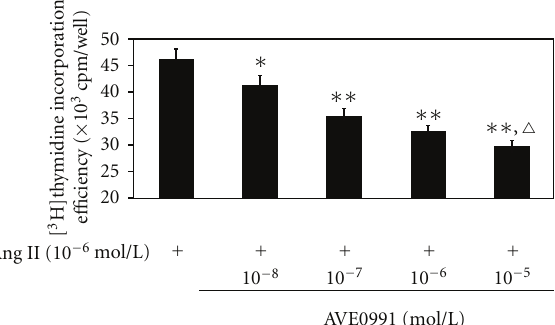
Figure 2: The e ff ect of various concentrations of AVE0991 on the VSMCs [ 3 H]thymidine incorporation e ffi ciency when stimulated with Ang II. ∗ P < 0 . 05; ∗∗ P < 0 . 01 versus control group; (cid:5) P < 0 . 05 versus Ang II + AVE0991 (10 − 6 mol/L) group; n =